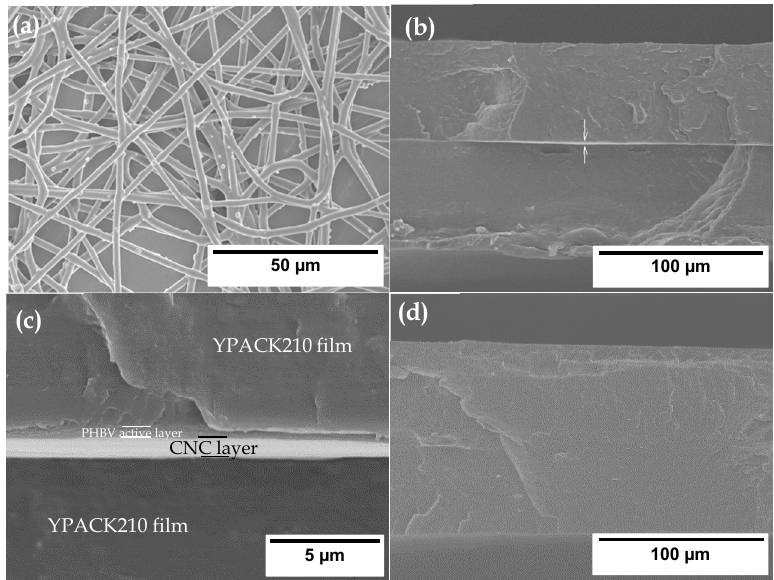
Figure 2. Scanning electron microscopy (SEM) micrographs of ( a ) the electrospun fibers of the cheese whey (CW) derived poly(3-hydroxybutyrate- co -3-hydroxyvalerate) (PHBV) containing 2.5 wt% oregano essential oil (OEO) + 2.25 wt% zinc oxide nanoparticles (ZnONPs) and of the active multilayer films ( b , c ) with cellulose nanocrystal (CNC) coating and ( d ) without CNC coating. Images taken at 800×, 500×, and 6000× show scale markers of 50, 100, and 5 µm, respectively.